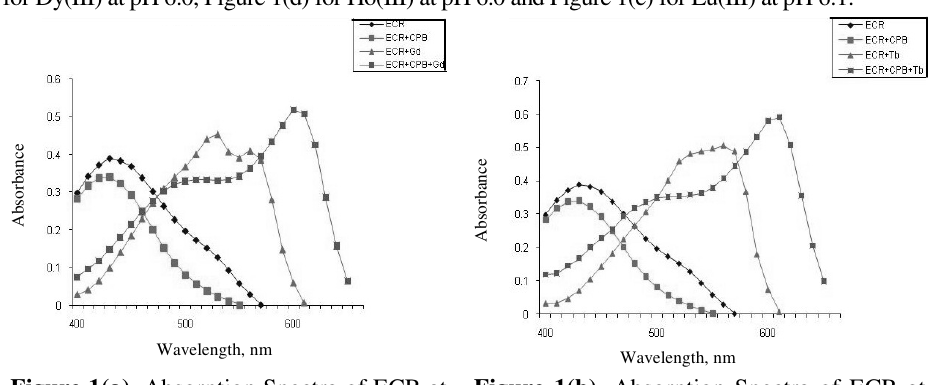
Figure 1(b). Absorption Spectra of ECR at pH 6.2 for Tb